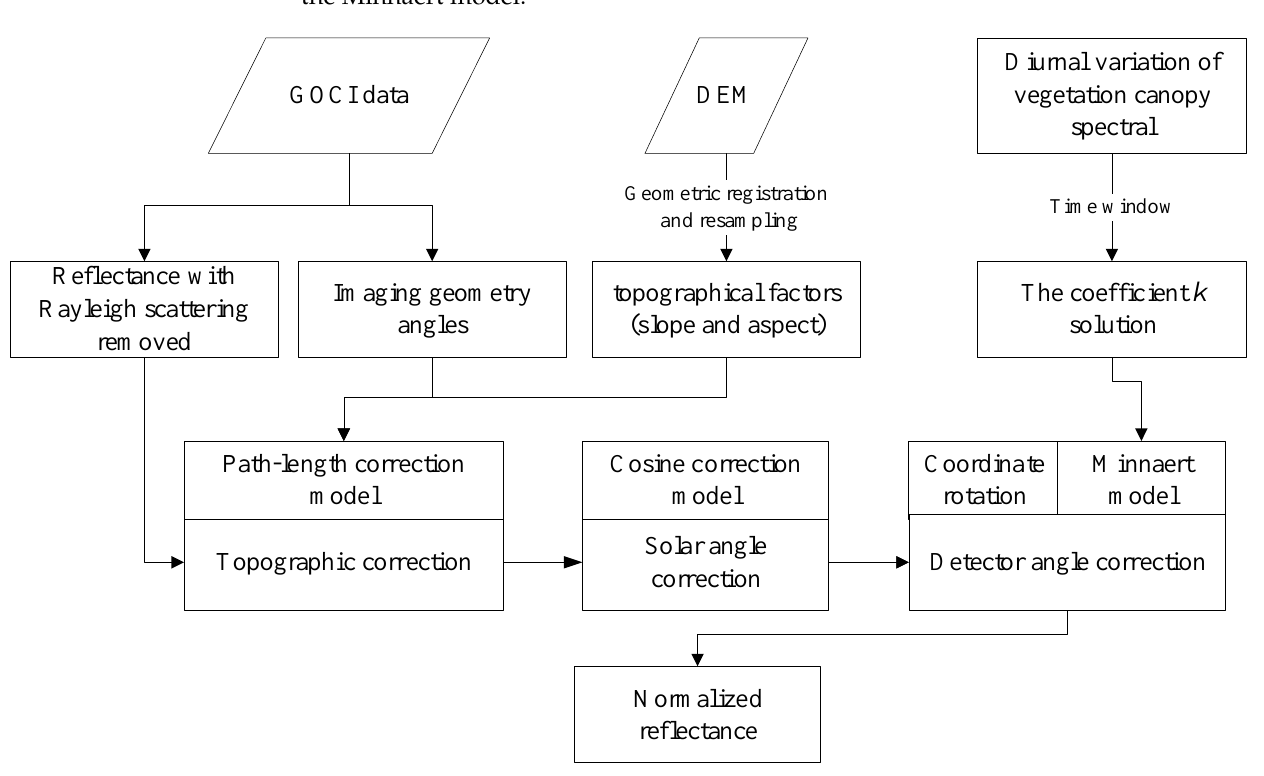
Figure 1. Schematic showing the workflow of the proposed method.